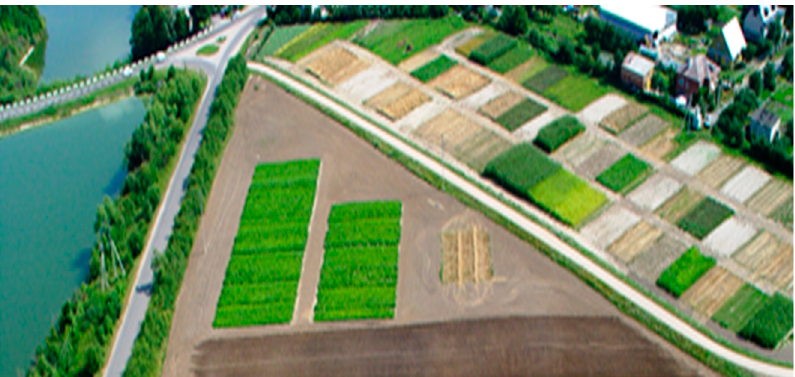
Figure 6. The long-term field experiment conducted at Vytautas Magnus University, Kaunas, Lith- uania (54°53 ′ N, 23°50 ′ E). nia (54 ◦ 53 (cid:48) N, 23 ◦ 50 (cid:48)